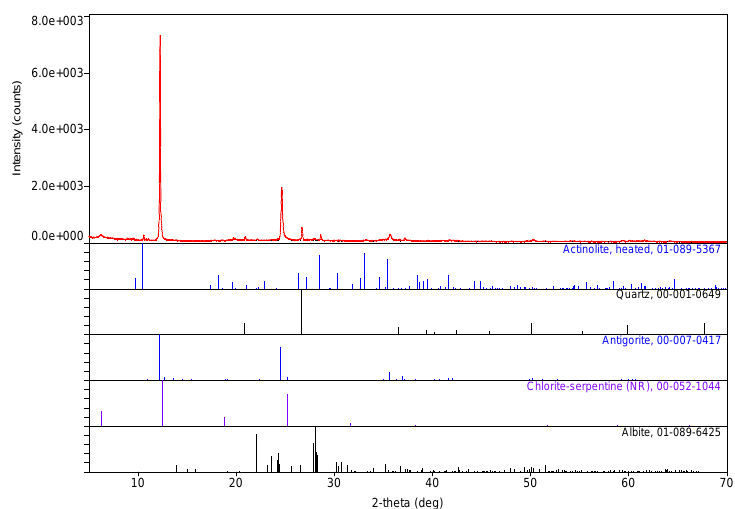
Figure A1. XRPD pattern for specimen a. XRPD patterns of indexed phases: heated actinolite (PDF# 01-089-5367), quartz (PDF# 00-001-0649), antigorite (PDF# 00-007-0417), chlorite–serpentine (NR) (PDF# 00-052-1044) and albite (PDF# 01-089-6425) are presented in the form of straight intensity lines at the bottom of the pattern.